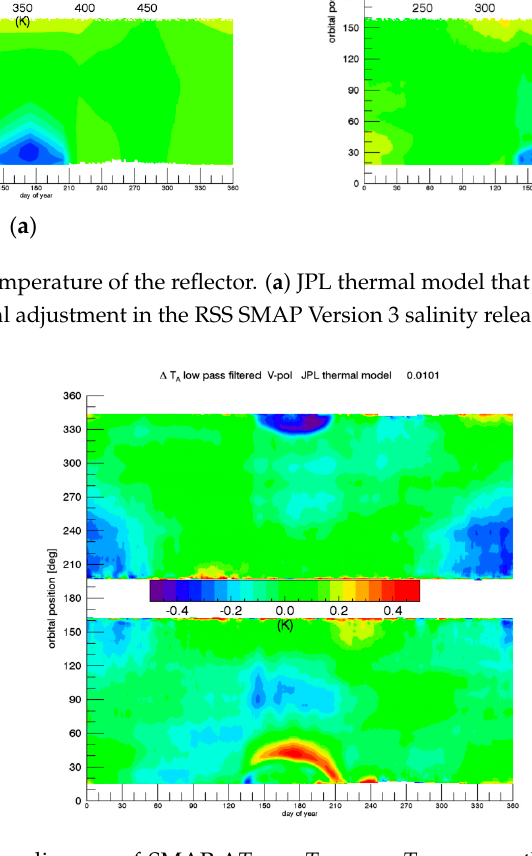
Figure 17. Hovmoeller diagram of SMAP ∆ T A = T A , meas − T A ,exp over the open ocean using the JPL thermal model for the SMAP mesh antenna. The x -axis is time (day of year) and the y -axis